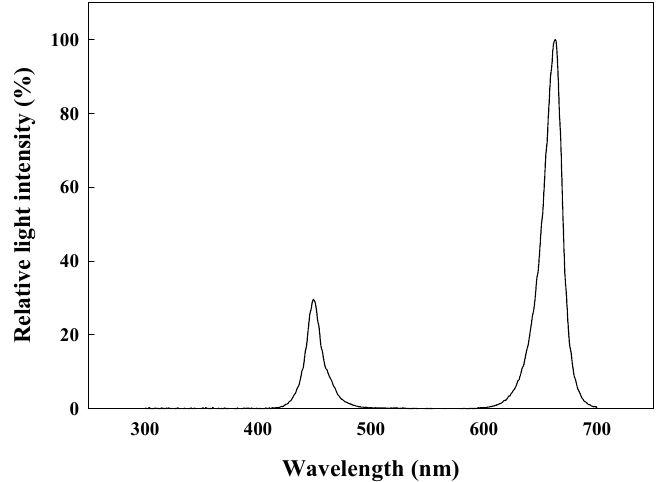
Figure 5. Relative spectral distribution of RB LEDs (red:blue = 8:2) used in a closed-type plant production system.